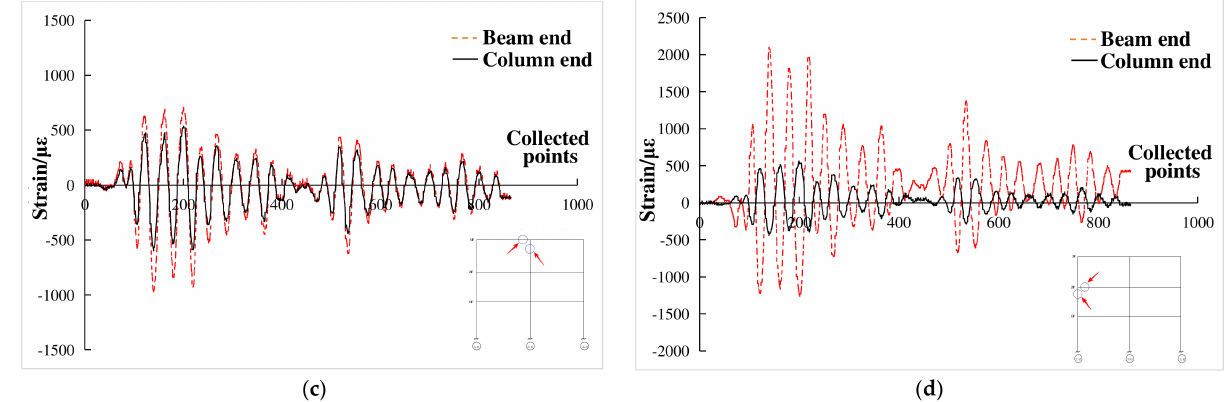
Figure 20. Strain at beam end and column end of composite frame. ( a ) Nodes in the first layer; ( b ) Nodes in the second layer; ( c ) Nodes in the third layer; ( d ) The left side node of the second layer. Under the action of El Centro wave, Taft wave, and Lanzhou artificial wave, the peak strain of mid-story beam and column steel in the composite frame structure is shown in Figure 21. It was found that when the input peak acceleration continuously increased, the strain values at the beam end and column end were also increased, but the strain at the column end had been in elastic strain. At the same time, comparing the influence of three seismic waves on the peak strain of beam end and column end, the descending order was Taft wave, El Centro wave, and Lanzhou artificial wave.